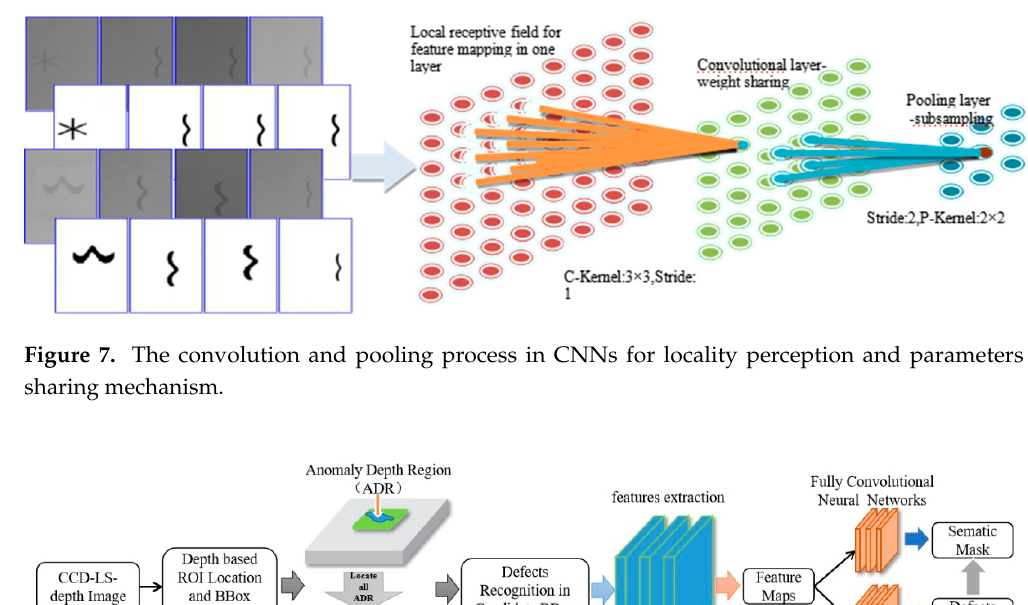
Figure 7. The convolution and pooling process in CNNs for locality perception and parameters sharing mechanism.